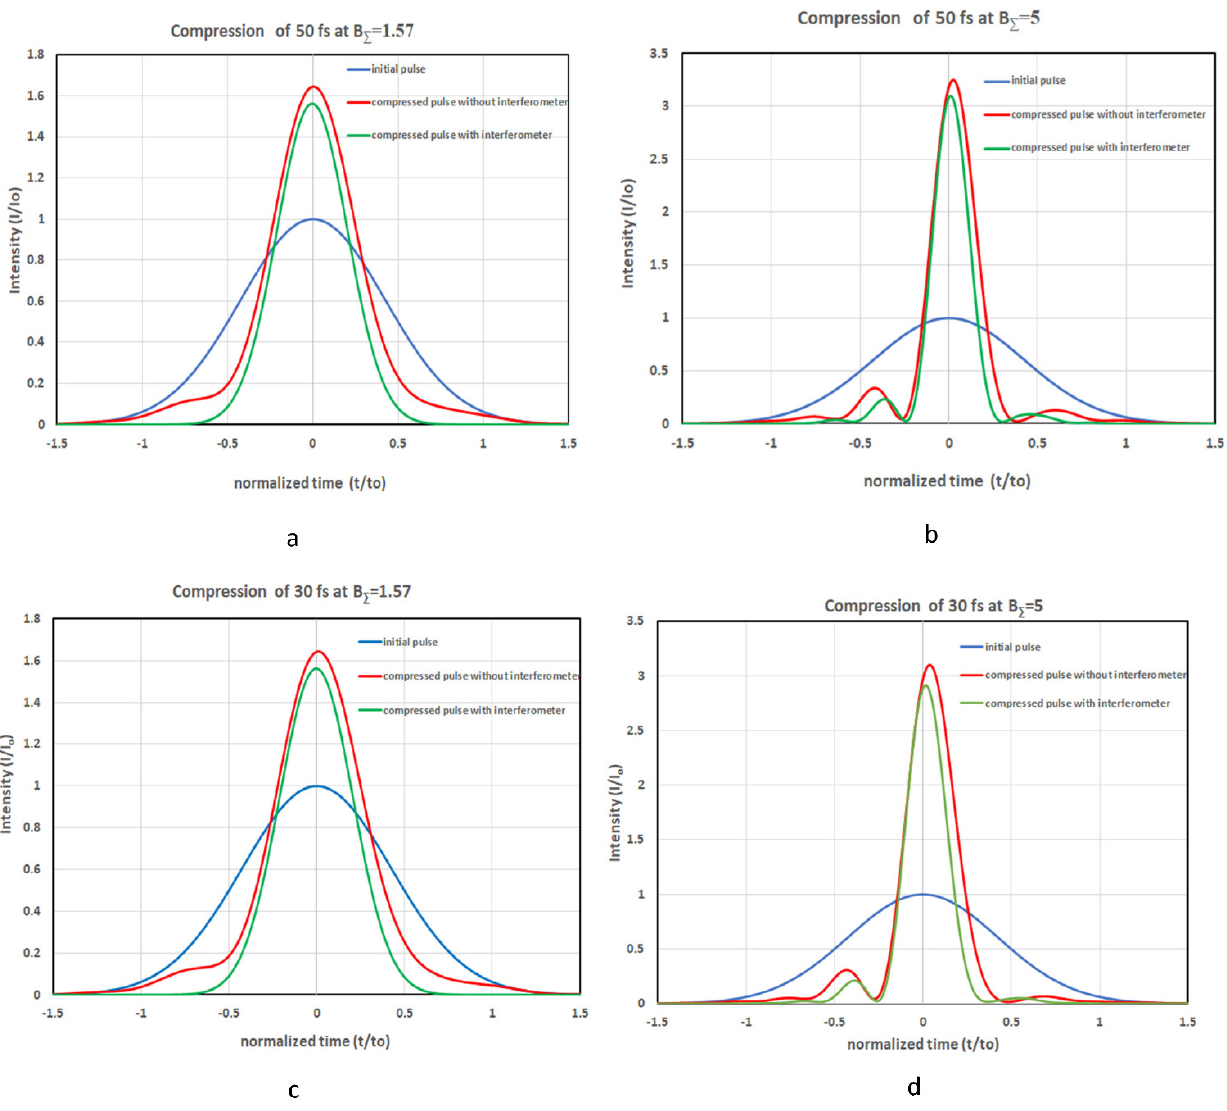
Photonics 2021 , 8 , x FOR PEER REVIEW Figure 4. Shapes of the initial pulse, compressed pulse in the scheme with interferometer (Figure 1a) and compressed pulse in the scheme without interferometer (Figure 1b) for 50 fs ( a , b ) and 30 fs ( c , d ) input pulses at B Σ = π /2 ( a , c ) and B Σ = 5 ( b , d ).